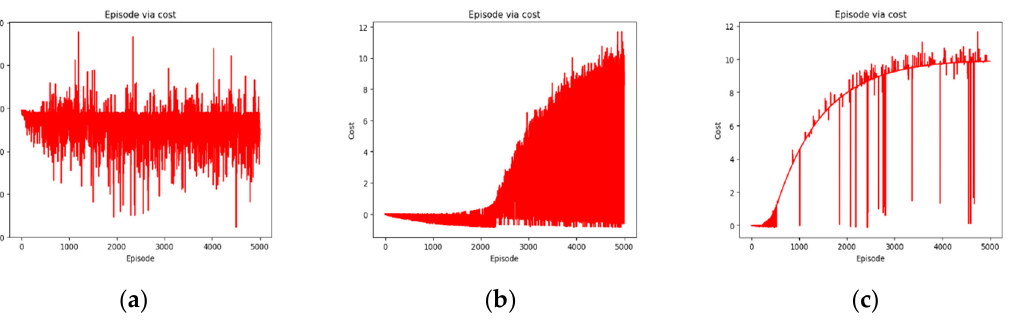
Figure 6. Graph of step changes during training. ( a ) Steps of SARSA algorithm; ( b ) Steps of Q-learning algorithm; ( c ) Steps of the proposed Q-learning optimization algorithm.